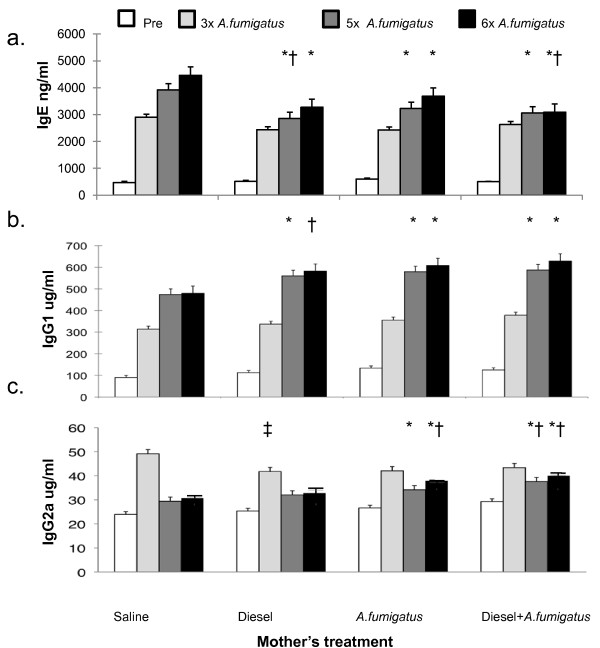
Ig induction in offspring after three, five and six doses of A. fumigatus. a) IgE was reduced after the fifth and sixth (p < 0.0001 on ANOVA), but not third (p = NS, ANOVA), doses among offspring mice whose mothers were exposed to either A. fumigatus or diesel exhaust particles or both. *p < 0.01, when compared to saline alone by Tukey HSD. † p < 0.05, when compared to A. fumigatus alone by Tukey HSD b) IgG1 was greater after the fifth, sixth (p < 0.0001 on ANOVA), but not third (p = NS, ANOVA), doses among mice whose mothers were exposed to either A. fumigatus or diesel exhaust particles or both. *p < 0.01, when compared to saline alone by Tukey HSD. †p < 0.05, when compared to saline alone by Tukey HSD. c) IgG2a was greater after the fifth, sixth (p < 0.0001 on ANOVA) dose among mice whose mothers were exposed to A. fumigatus or diesel exhaust particles plus A. fumigatus. *p < 0.01, when compared to saline alone by Tukey HSD. Levels also were greater among offspring of mothers that were exposed to both diesel exhaust particles and A. fumigatus when compared to offspring of mothers treated either with diesel exhaust or A. fumigatus alone, p < 0.01.
†p < 0.01, when compared to diesel exhaust particles alone by Tukey HSD. ‡ p < 0.05 on ANOVA and when compared to saline alone by Tukey HSD. Sample sizes corresponding to the figures vary as follows: Saline 11-14; Diesel 11-15; A. fumigatus: 8-18; Diesel and A. fumigatus 13-25.